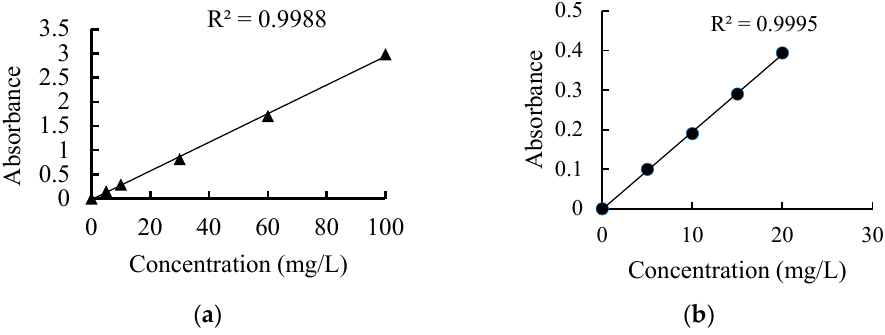
Figure 2. The quantitative standard curves of CB ( a ) and MCB ( b ) suspension using SDS as dispersant by measuring its absorbance at 800 nm.